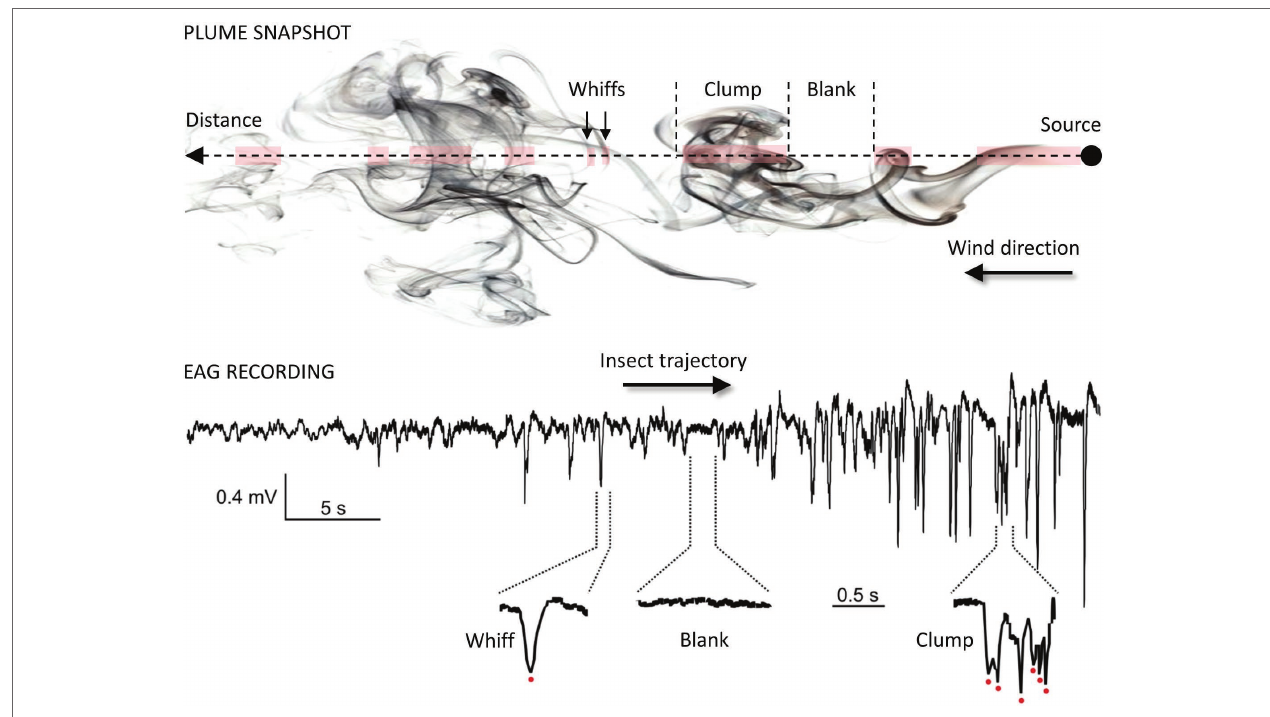
FIGURE 4 | Temporal structure of the odor plume. Plume snapshot (upper part): the wind transports odorants away from the source along its main direction. The mean odorant concentration in the odor plume decreases with the square of the distance but local vertices mix together odorized and clean air, making the local odor concentration vary considerably around the average. As a result, odor plumes are highly intermittent signals, consisting of series of whiffs, clumps and blanks (odor/no-odor events). Foraging insects cannot rely on a chemical gradient but use the fast temporal dynamic of the plume to locate distant mates and host plants (Budick and Dickinson, 2006; Cardé and Willis, 2008). EAG recording (lower part): the complex structure of odor plumes can be visualized with the EAG technique (Vickers et al., 2001; Riffell et al., 2008; Nagel and Wilson, 2011) since the insect antenna responds gradually and dynamically to odor stimuli. Here, the EAG was recorded from an Agrotis ipsilon antenna attached to a walking red palm weevil ( Rhynchophorus ferrugineus ). The weevil was attracted to an odor source containing 10 µg of its aggregation pheromone (4-methyl-5-nonanol, ferrugineol) mixed with 10 µg of the main component of the A. ipsilon pheromone, (Z)7-dodecenyl acetate (Z7-12:Ac). Z7-12:Ac is thus used as a tracer of ferrugineol. The distance between the starting point of the insect and the odor source it reached was 1.75 m. Portions of the EAG recording corresponding to a whiff, a blank, and a clump of whiffs are enlarged and show single detection events (red